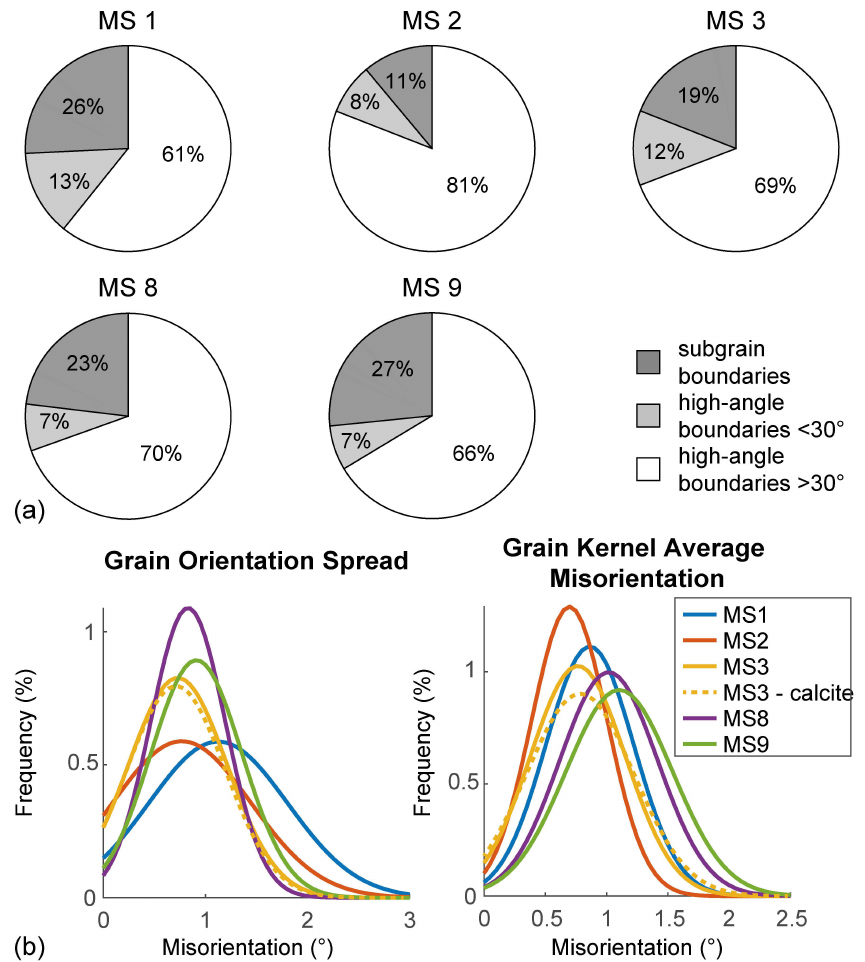
Figure 8. ( a ) Comparison of the amount of low-angle and high-angle quartz-quartz grain boundaries. Pie charts show the amount of low-angle or subgrain boundaries (<10 ◦ ) inclusive of the “subtwin” grain boundaries (rotations around [c] with angles >50 ◦ and <60 ◦ ), high-angle grain boundaries <30 ◦ , and high-angle grain boundaries >30 ◦ per sample. ( b ) Compilation of the grain orientation spread and the grain kernel average misorientation of the samples using kernel density estimations. For further explanations, see